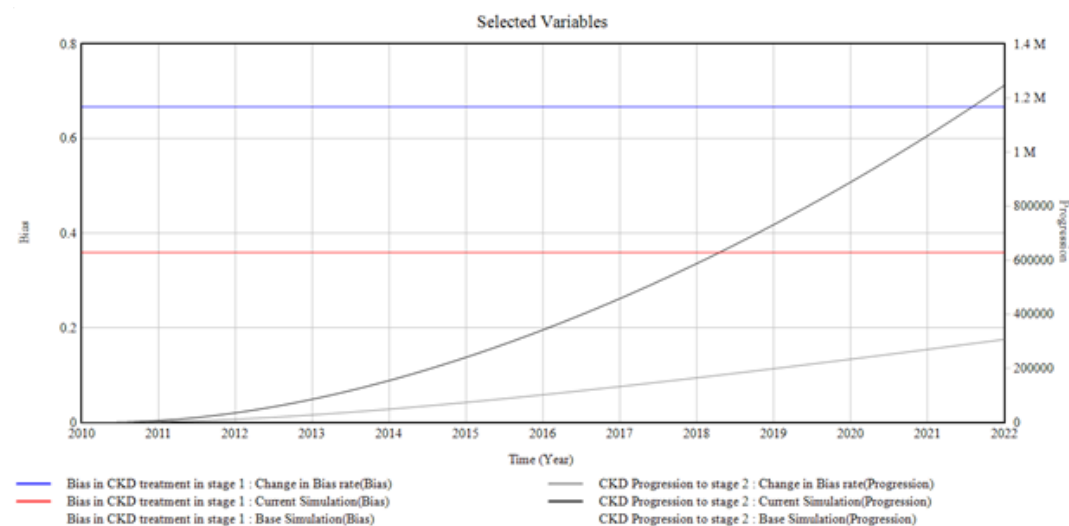
Figure 3. The Bias Rate in CKD in Stage 1 vs. CKD Progression to Stage 2 CKD.